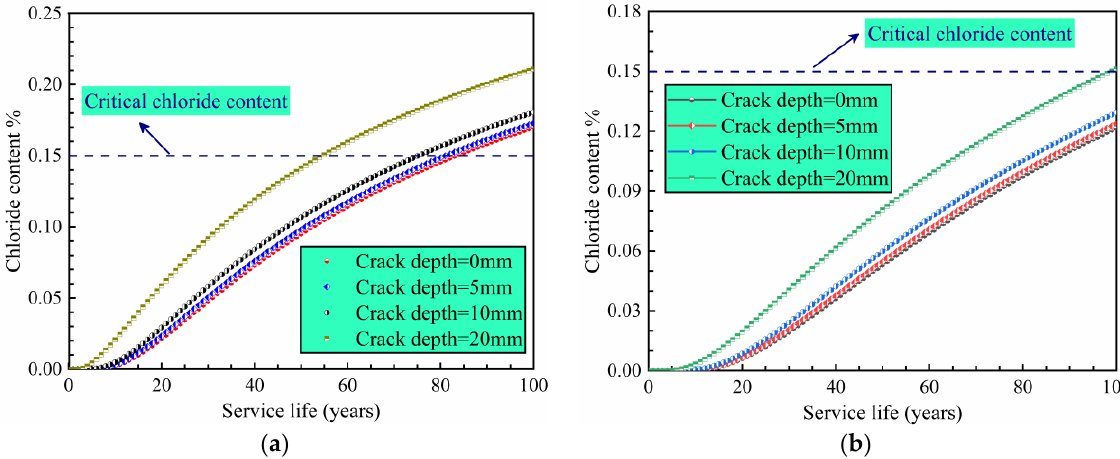
Figure 11. Chloride content as a function of time in a structure protection layer with a thickness of ( a ) 40 mm and ( b ) 50 mm.